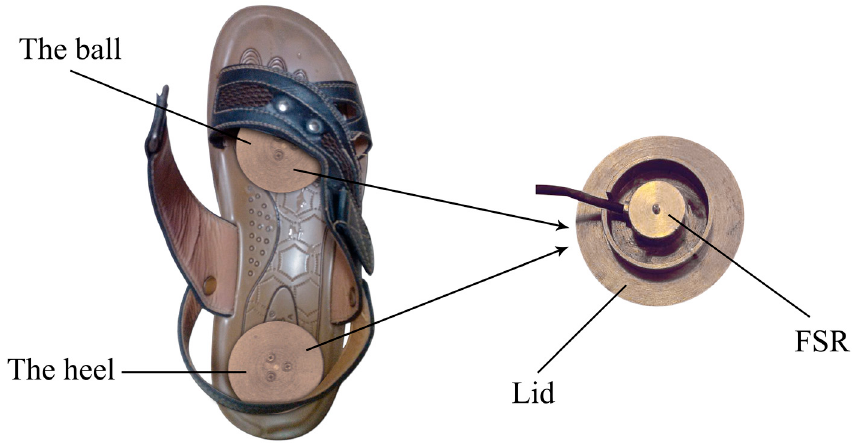
Figure 1. FSRs placed inside one shoe with one in the ball and the other in the heel. A lid is made to enlarge the press area.